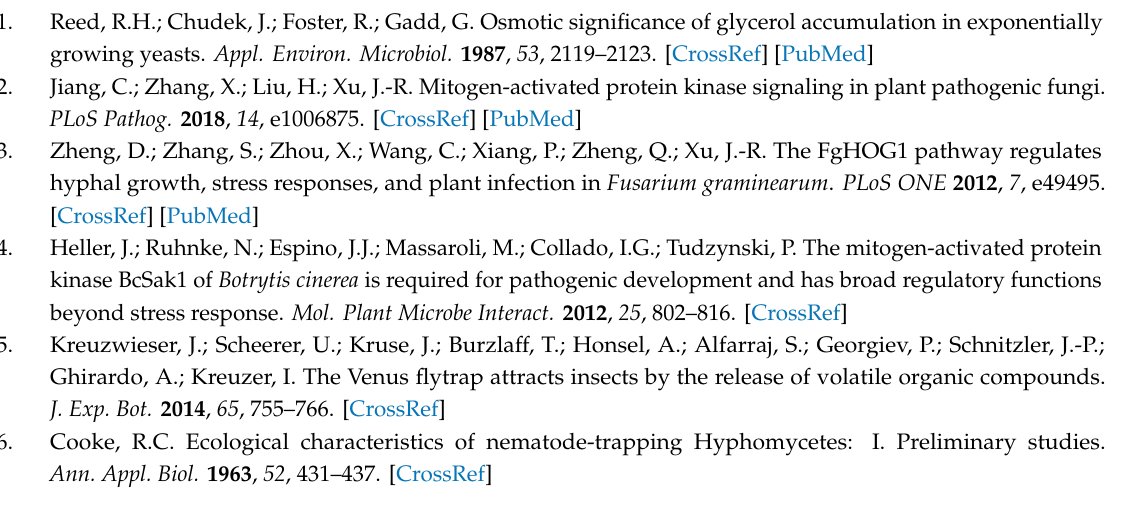
Figure S1: Southern blot analysis of targeted gene deletion mutants generated in the ku70 background, Table S1: Primer used in this